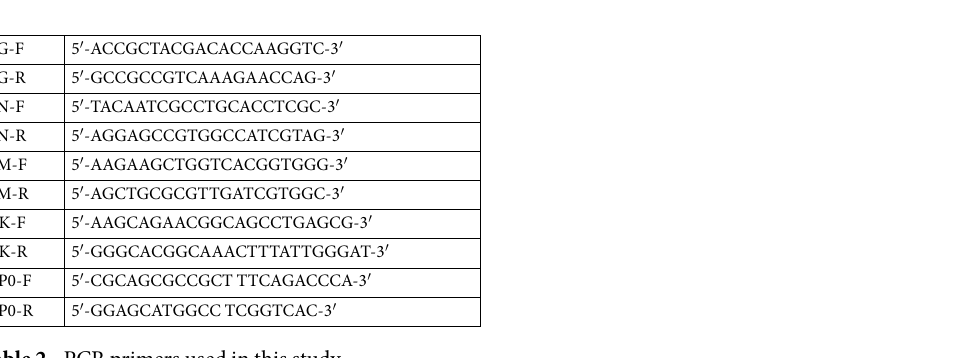
Table 1. sgRNAs used in this study.